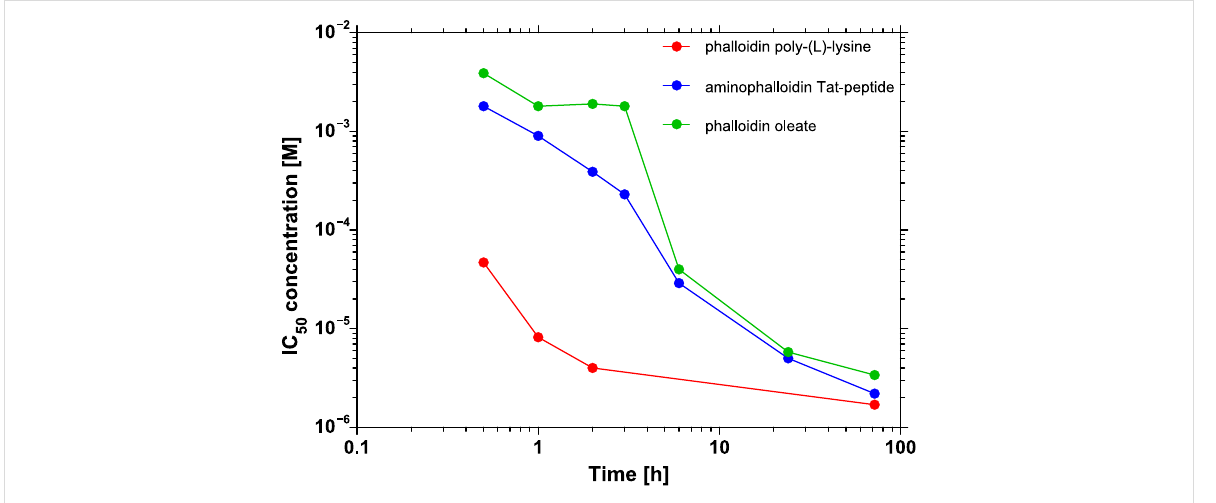
Figure 5: Time course of uptake in NIH 3T3 cells of three phalloidin derivatives as measured by the cytotoxicity after 72 h incubation during which the toxins were washed off after various exposure times.